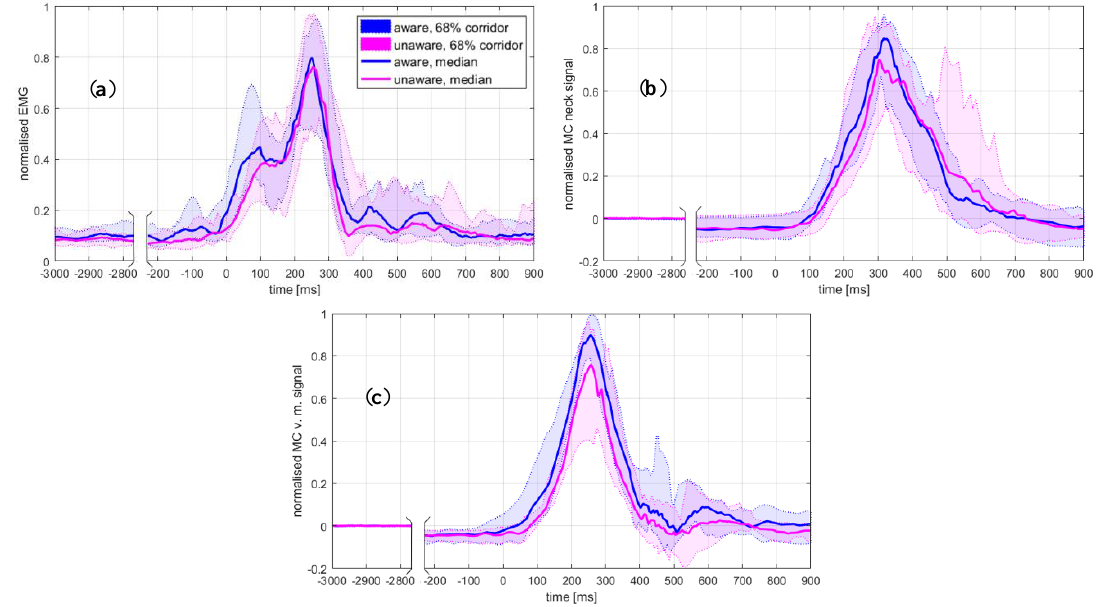
Figure 3. ( a ) EMG linear envelope for the upper trapezius, ( b ) muscle-contraction (MC) sensor signal for the upper trapezius, ( c ) MC signals for vastus medialis. Note that the median values of the MC signals ( b , c ) before the impact are below the baseline estimated for the interval − 3.0 to − 2.5 s, due to the gravity component acting on the sled’s downwards motion along the 10 ◦ inclined rails, e ff ectively reducing the muscle force needed to maintain the volunteer’s initial posture before the